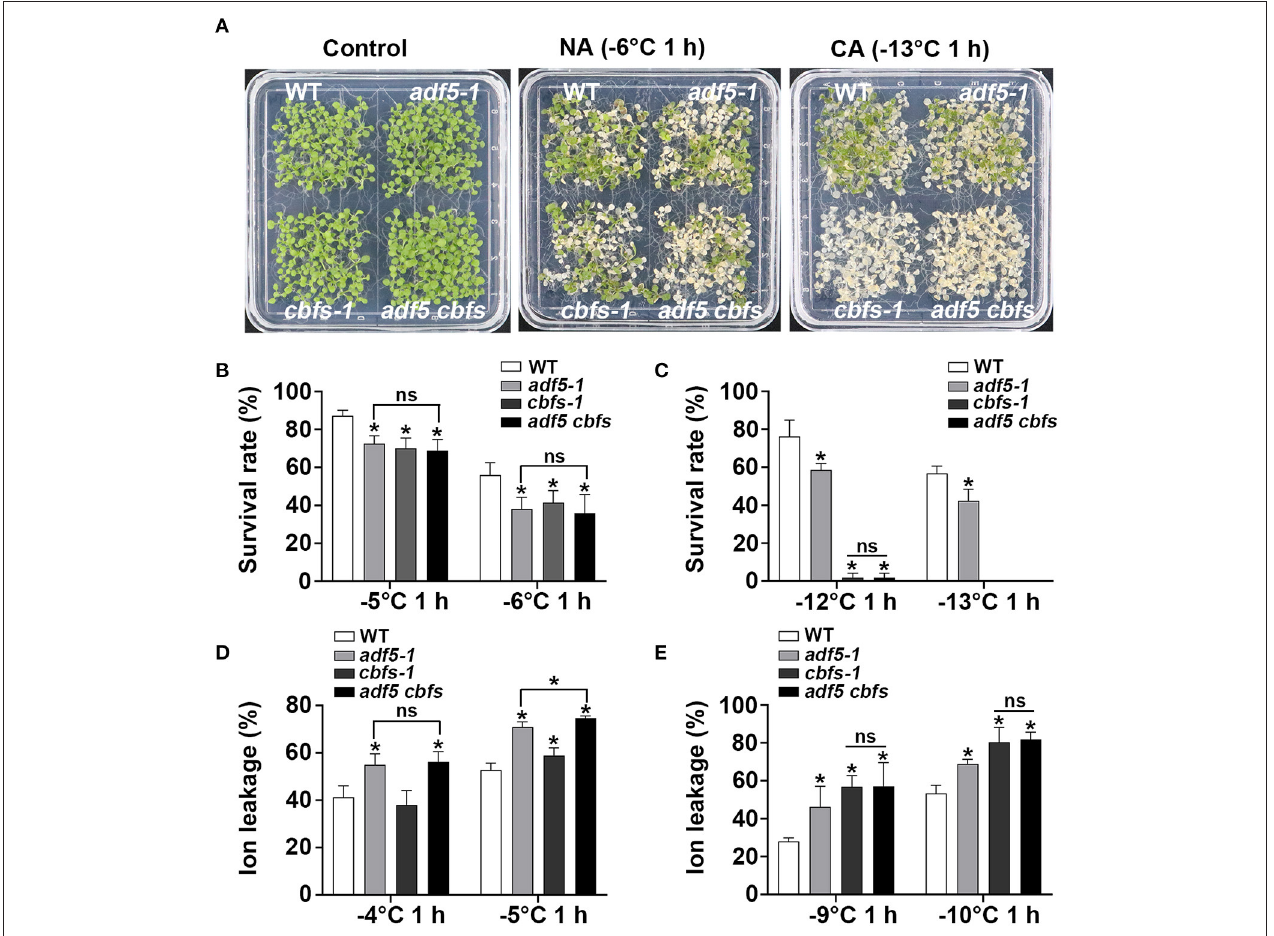
FIGURE 4 | ADF5 is the genetic downstream of CBFs. (A) Freezing phenotypes of WT, adf5-1 , cbfs-1, and adf5 cbfs under NA or CA conditions. (B,C) Survival rate of WT, adf5-1 , cbfs-1 , and adf5 cbfs . After 3–5 days of recovery under normal growth conditions, the survival rate was calculated. The data are the means of three biological replicates ± SD ( n = 40 for each replicate). Asterisks indicate statistically significant differences and ns is not significant ( P < 0.05, one-way ANOVA with a Tukey’s multiple comparisons test). (D,E) Ion leakage of WT, adf5-1 , cbfs-1, and adf5 cbfs . After 3 weeks of normal growth in soil, the fully developed rosettes of seedlings were used for freezing treatment to obtain ion leakage under NA or CA conditions. The data are the means of three biological replicates ± SD ( n = 5 for each replicate). Asterisks indicate statistically significant differences and ns is not significant ( P < 0.05, one-way ANOVA with a Tukey’s multiple comparisons